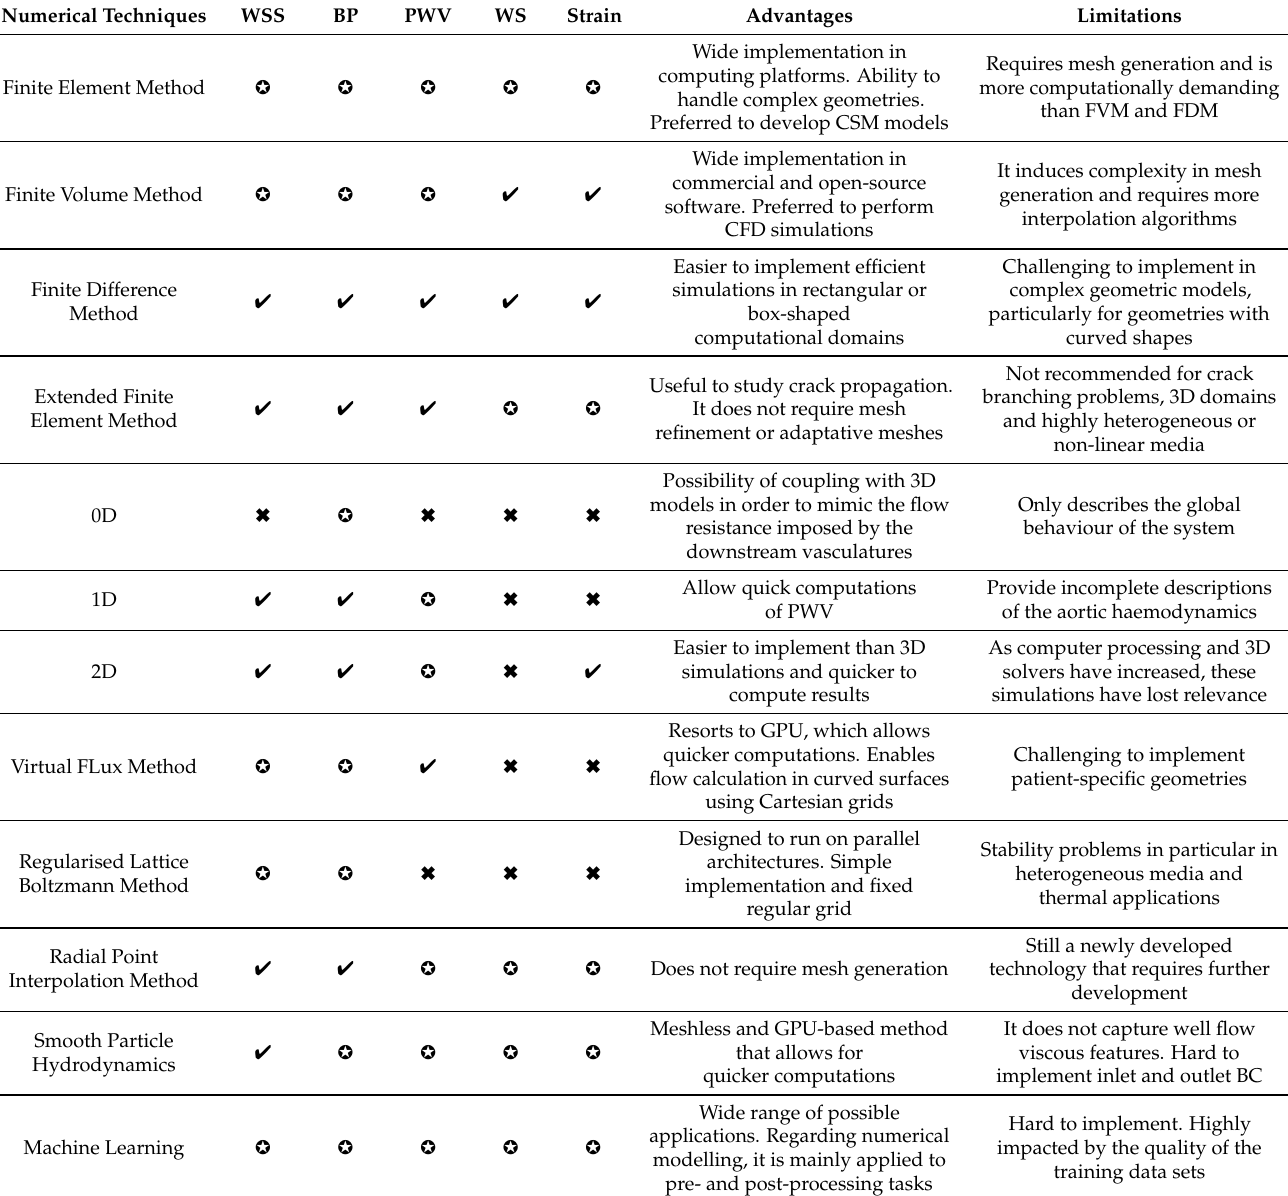
Table 1. Applications, advantages and limitations of the identified computational